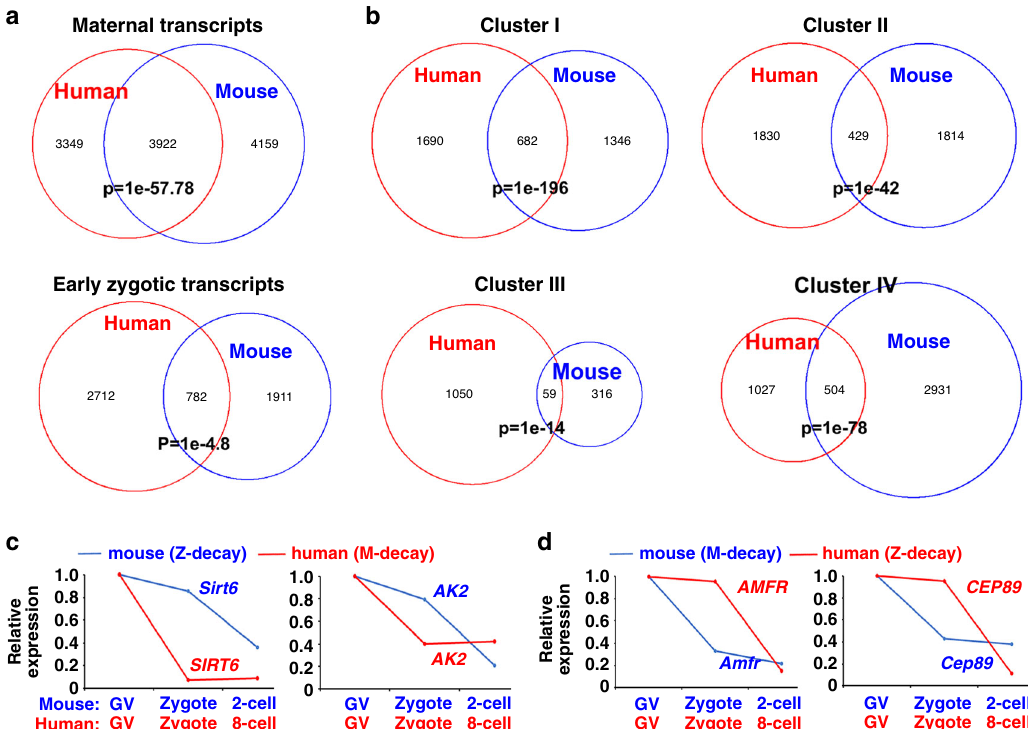
Fig. 2 Comparisons of the maternal mRNA degradation pattern between mouse and human. a Venn diagram showing the overlap of maternal and zygotic transcripts in GV oocytes and early embryos (mouse: 2-cell; human: 8-cell) from mouse and human. b Overlap of human and mouse maternal transcripts in Clusters I – IV that are classi fi ed in Fig. 1b. c and d Relative expression levels of representative transcripts in human and mouse oocyte/ embryos at the indicated and zygotes, but accumulated in the nuclei of 8-cell embryos (Fig. 3g). The 3 ʹ -terminal uridylyl transferase 4 and 7 (TUT4/7)- dependent mRNA 3 ʹ -oligouridylation in mice participated in mRNA decay and sculpted the maternal transcriptome 12 . TUT7 , which is the downstream factor of TEAD4 30 , was also expressed in human oocytes at higher levels compared to TUT4 , but maternal TUT7 transcripts were removed during oocyte matura- tion and fertilization. Nevertheless, transient expression of zygotic TUT4/7 was detected from the 8-cell stage to the morula stage, with TUT7 levels being higher than those of TUT4 (Fig. 3f). The TUT7 expression levels peaked at the 8-cell stage and then rapidly decreased at the morula stage. The expression window of the human zygotic TUT4/7 gene overlapped with the time frame of Z-decay.